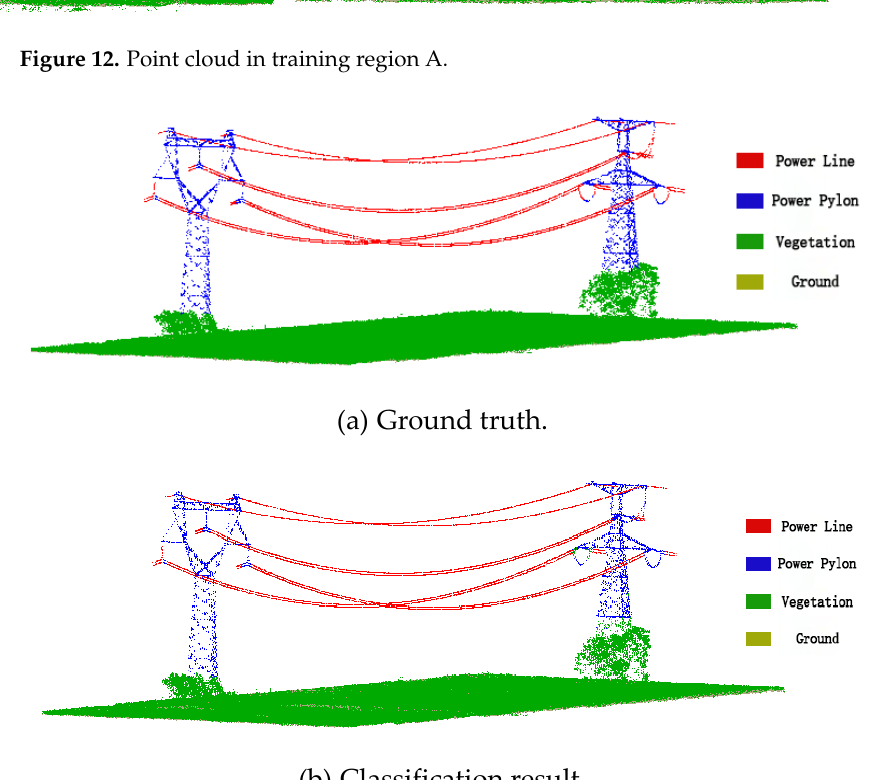
Figure 13. Classification result of region B point cloud.